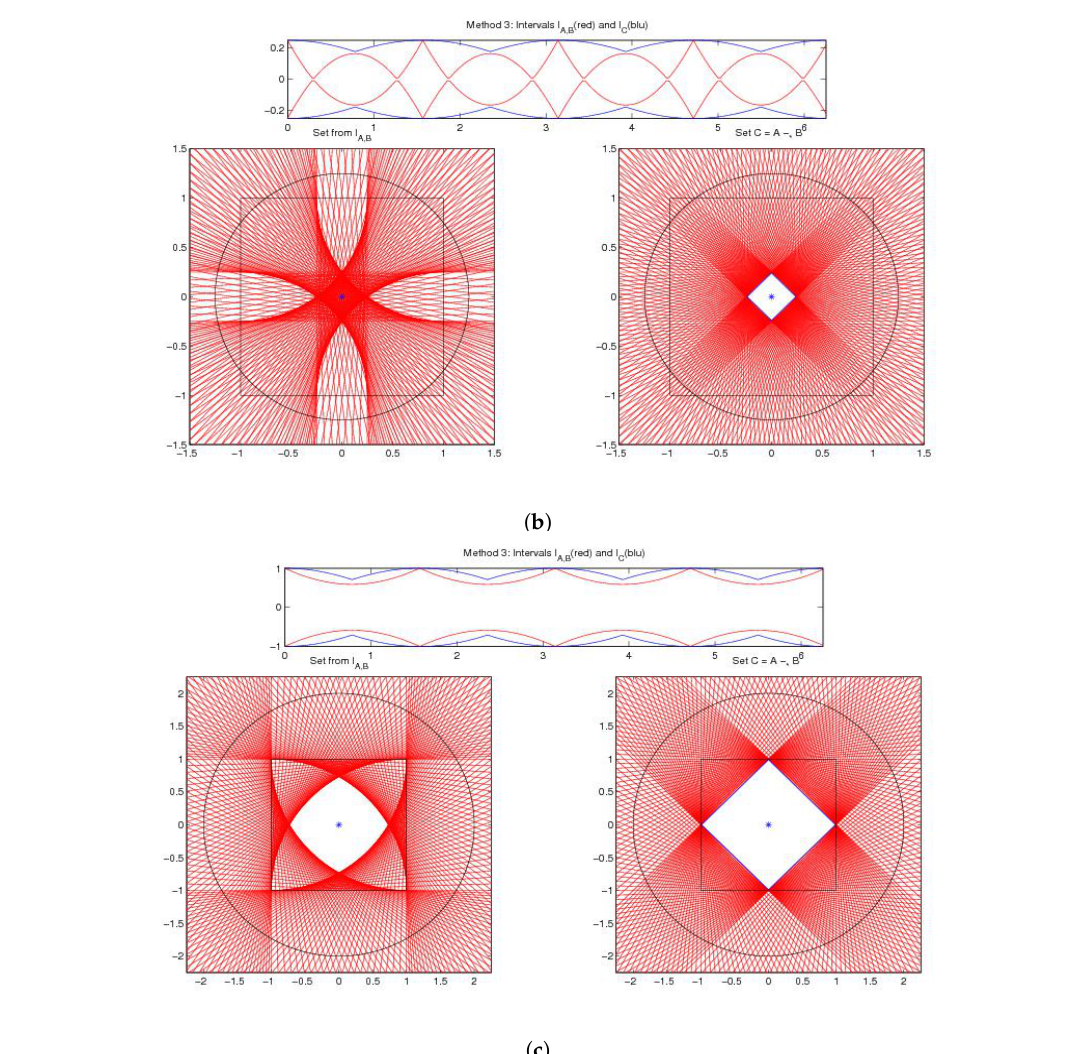
Figure 1. Example 1. g ∗ -difference C ∗ = A (cid:9) ∗ B µ for ( a ) top: µ = 0.5, ( b ) middle: µ = 1.25, ( c ) bottom: µ =